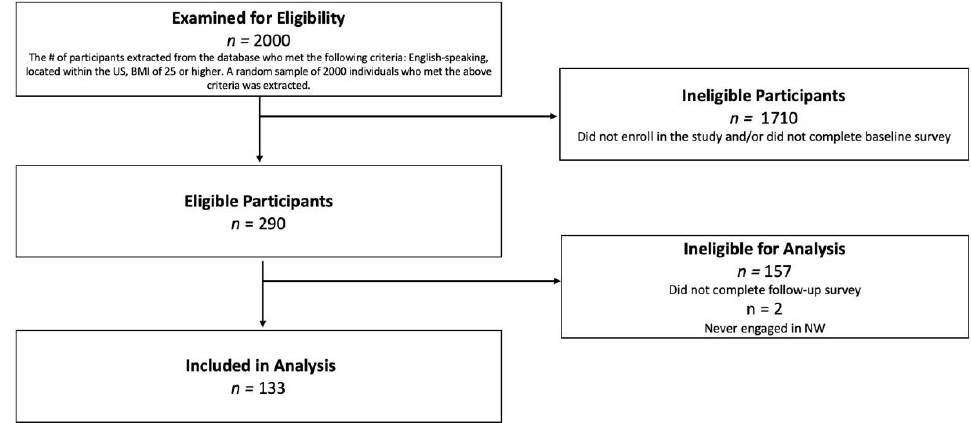
Figure 1. Diagram of study inclusion